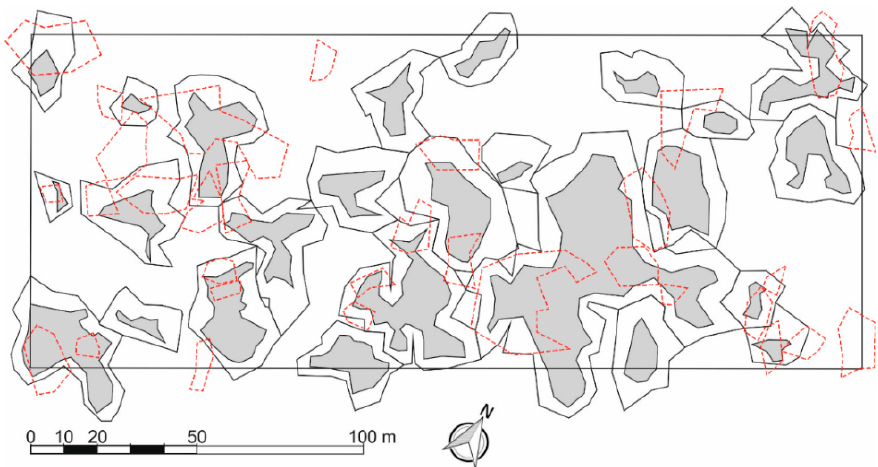
Figure 3. Spatial distribution of open and expanded gaps and of polygons of mapped natural regeneration on the permanent research plot Sitno.